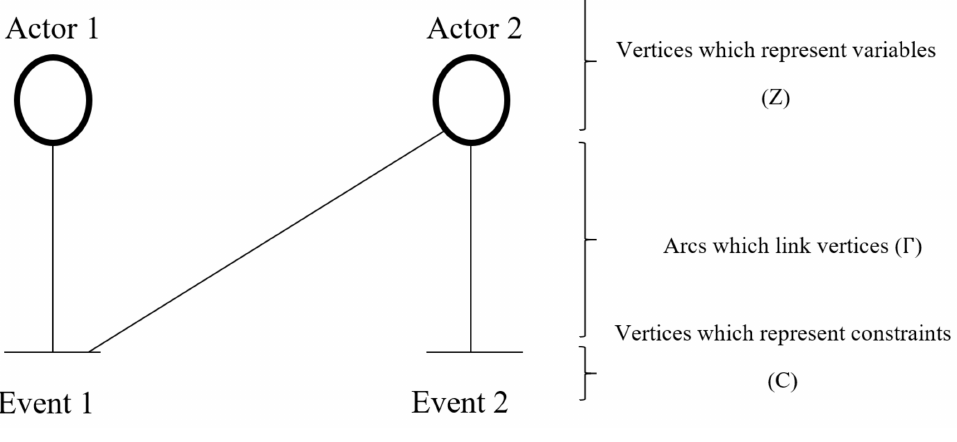
Figure 3. Illustration of a bipartite